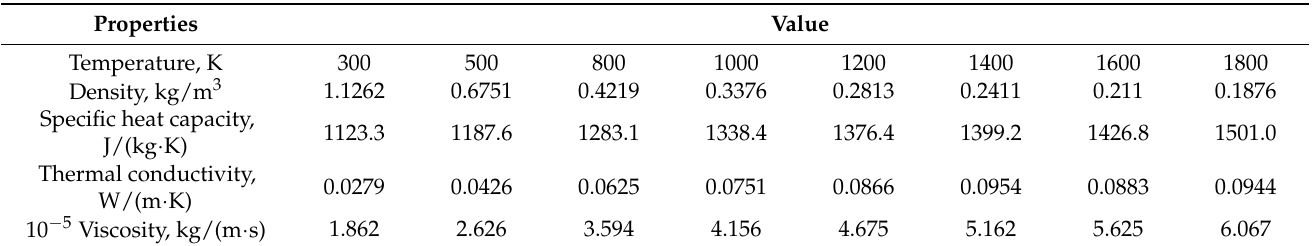
Table 2. Physical parameters of furnace